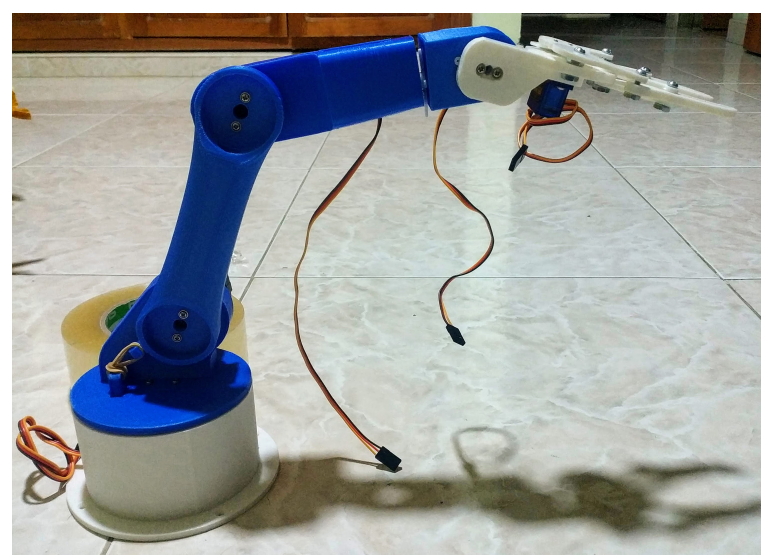
Figure 8. Robotic arm that was used for the execution of the case study.